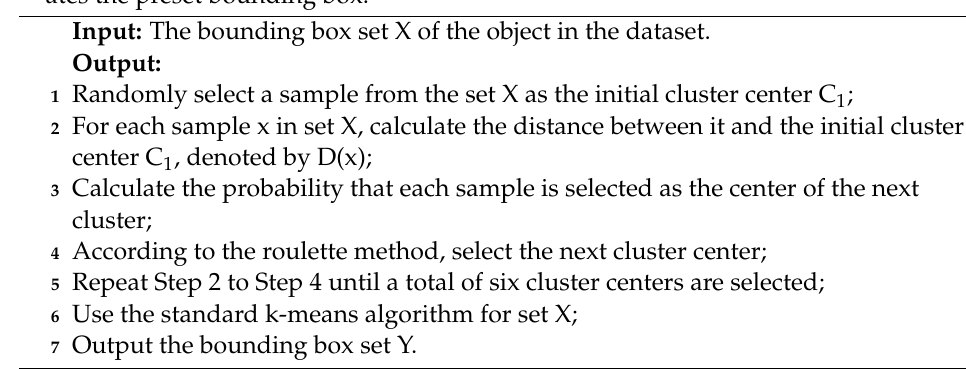
Algorithm 1: The process by which the K-means++ clustering algorithm gener- ates the preset bounding